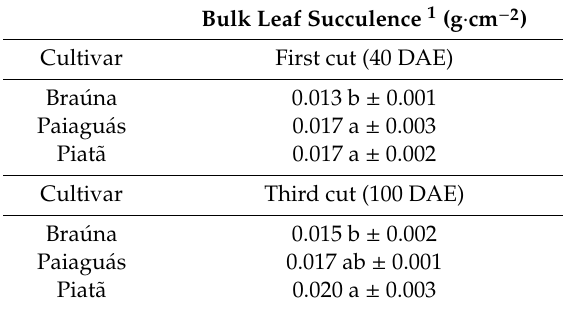
Table 4. E ff ect of soil water pressure head on leaf succulence ( Brachiaria brizantha cultivars) for the first and third cutting periods.